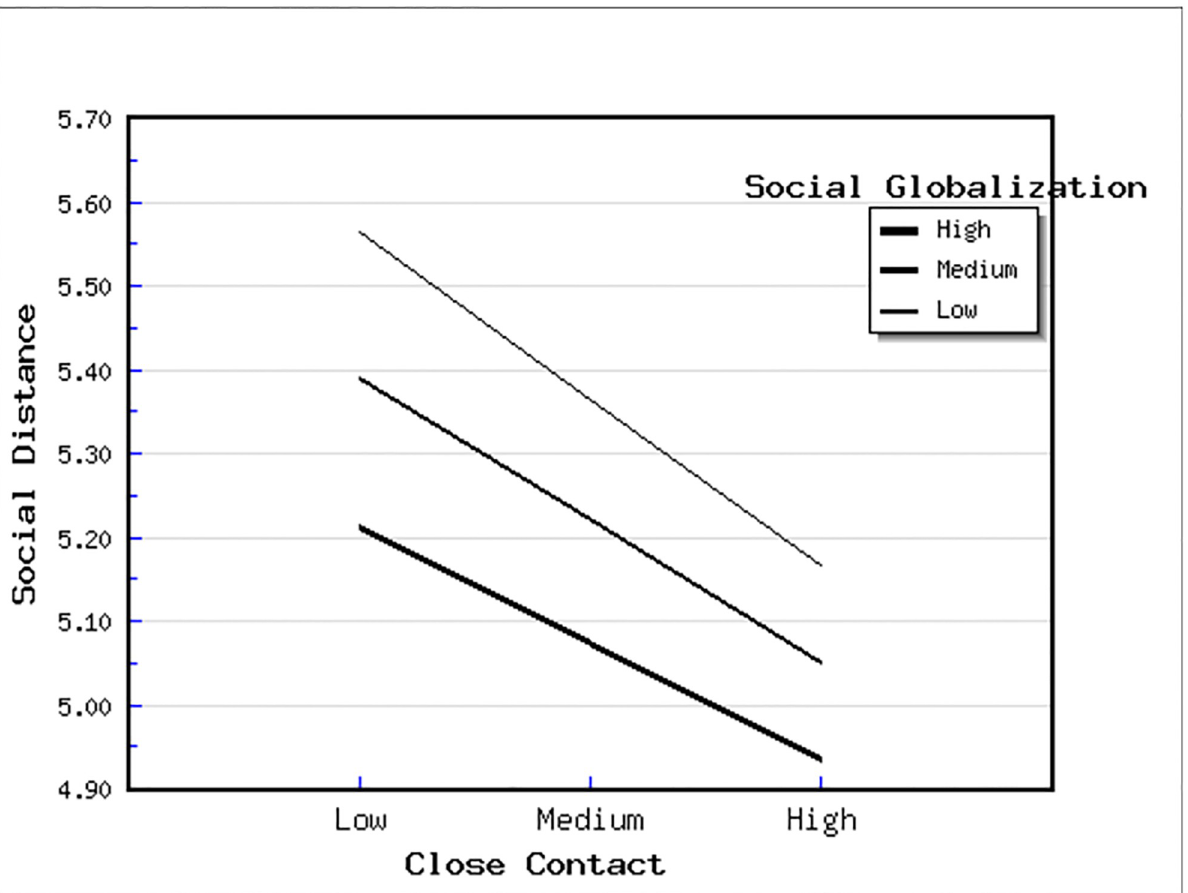
Fig 1. The interaction effect of close contact and globalization on social